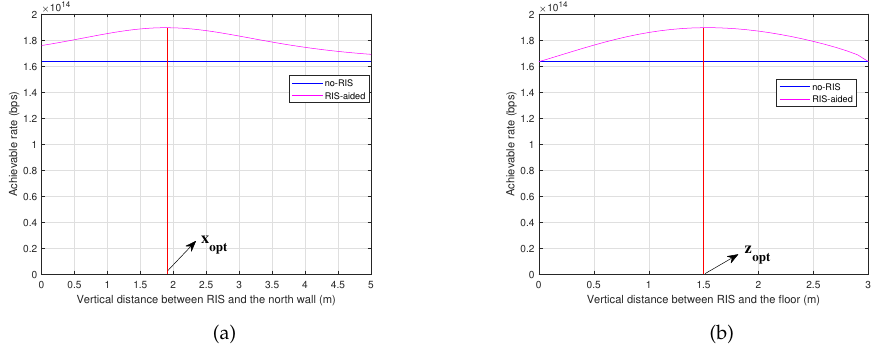
Figure 5. ( a ) Achievable rate on x-axis. ( b ) Achievable rate on z-axis.